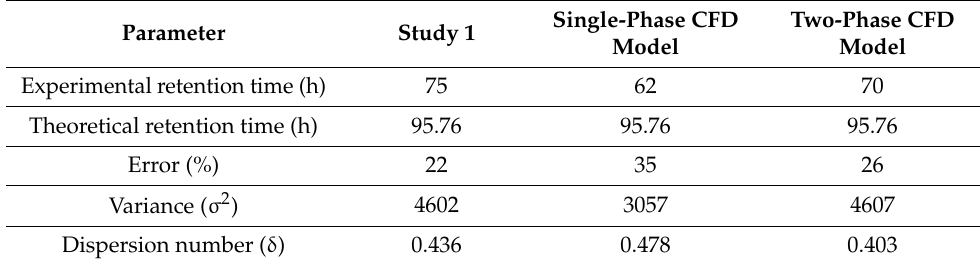
Table 3. Parameters obtained from experimental tracer study and CFD